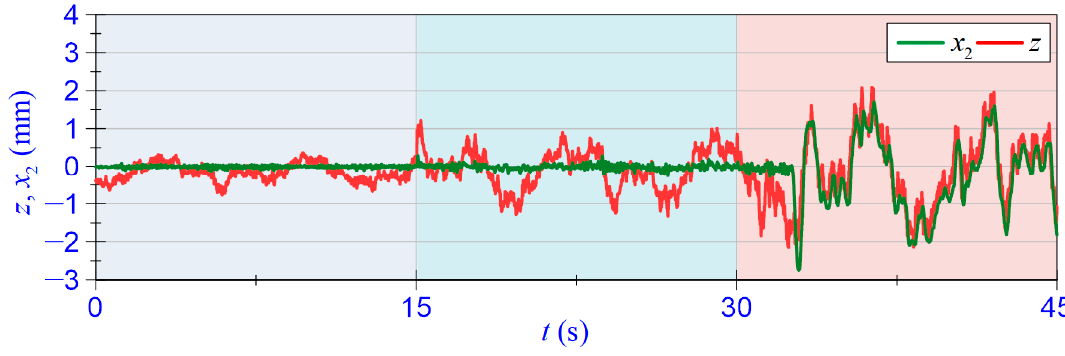
Figure 14. Time patterns of displacement (cid:1878) and (cid:1876) (cid:2870) —experiments.